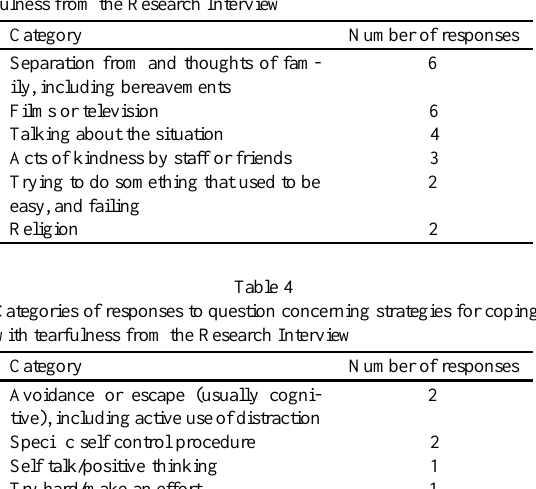
Table 3 Categories of responses to question concerning precipitants of tear-